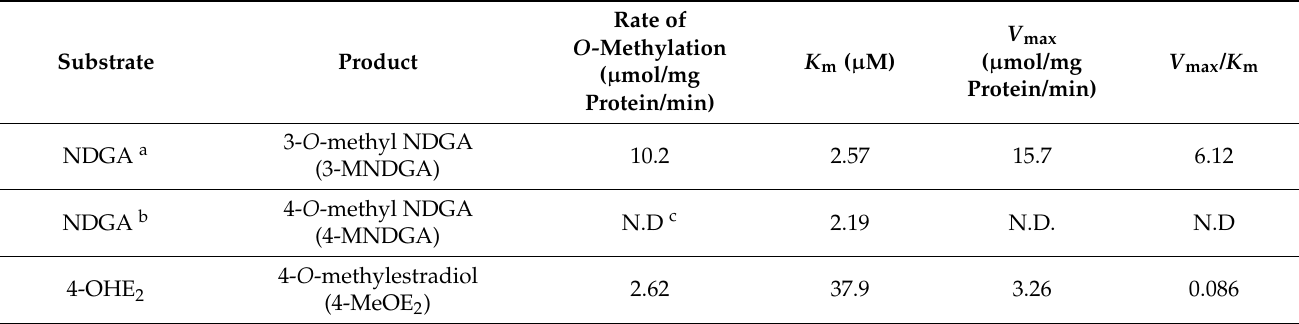
Table 1. Kinetic parameters in O -methylation of nordihydroguaiaretic acid (NDGA) and 4-hydroxyestradiol (4-OHE 2 ) by human recombinant soluble catechol O -methyl transferase (COMT).